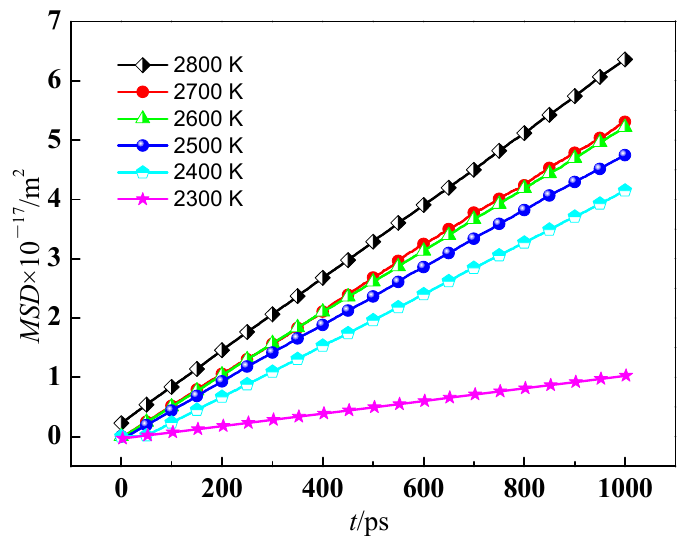
Figure 3. MSD curves at different temperatures. Table 1. Diffusion coefficient and activation energy of Ti-Al alloy at different temperatures. Temperature ( T /